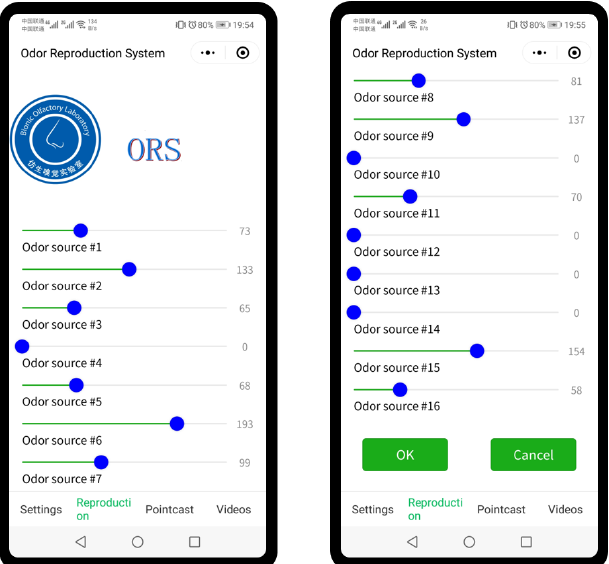
Figure 6. Mini-program for the odor reproduction